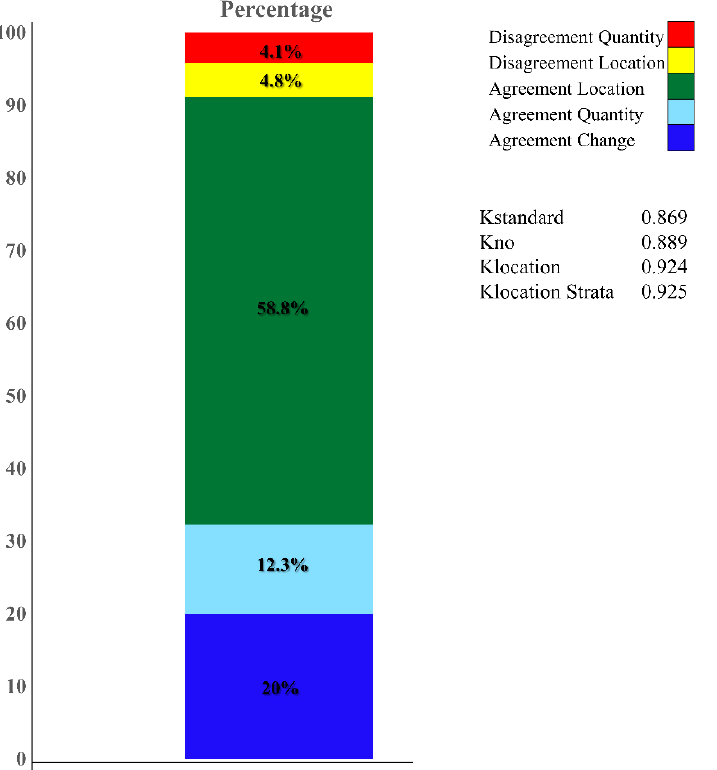
Figure 3. Statistics of Kappa parameters from the comparison of the simulated LULC map and the reference map.